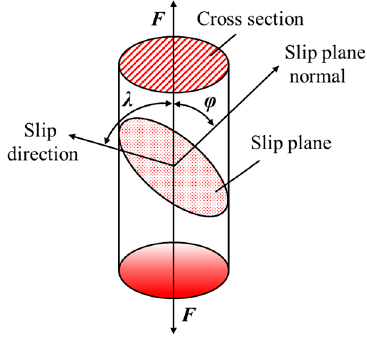
Figure 12. Slip deformation of a single-crystal specimen under uniaxial tension.